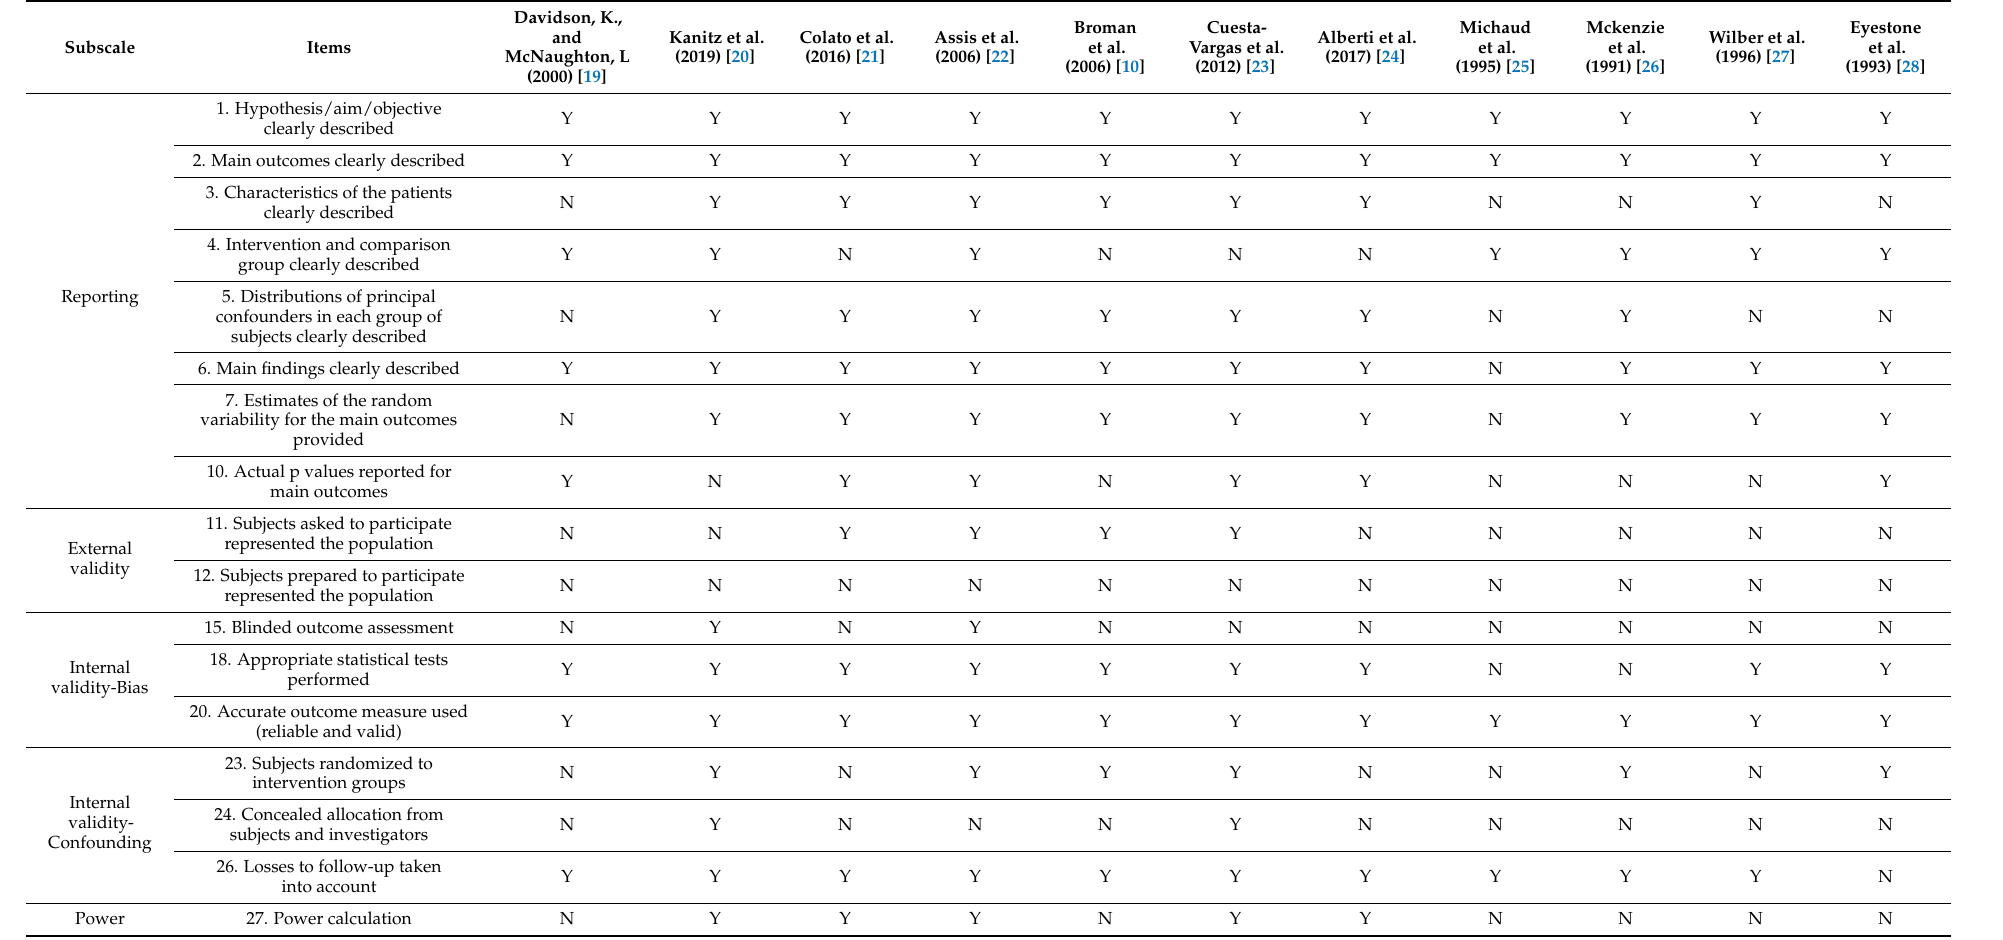
Table 1. Quality